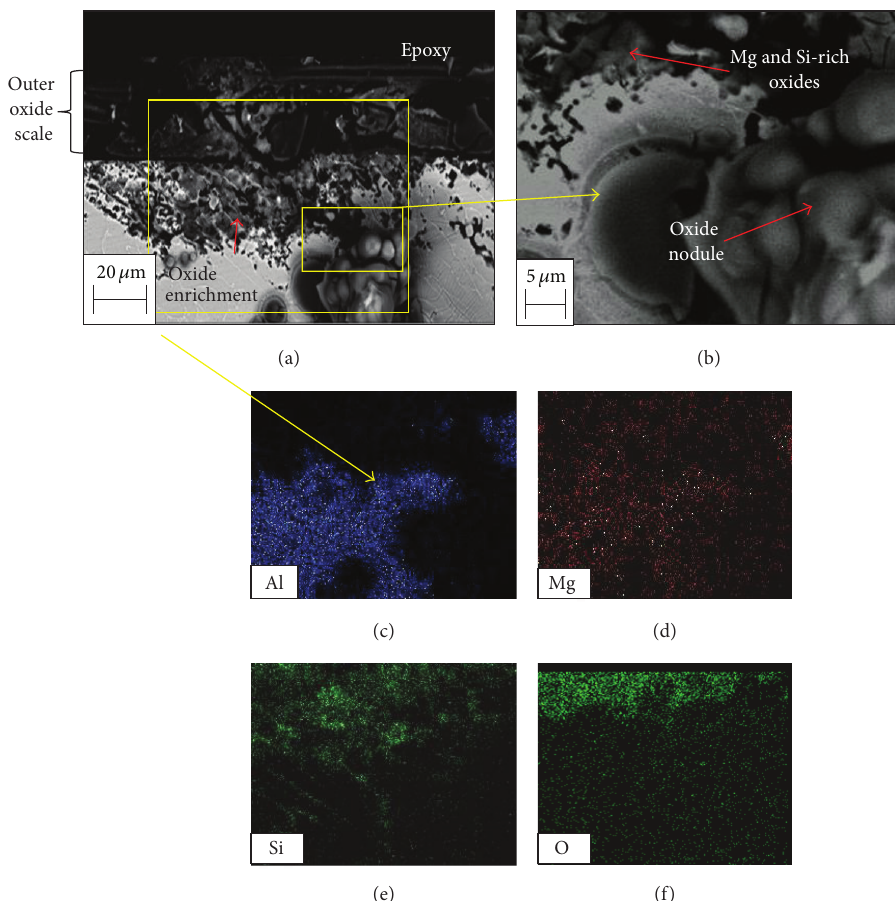
Figure 7: A cross-sectional image of fused metal part of welded AA6061 Al alloy oxidized at 600 ∘ C for 40 hours, (a) SEM image and (b) expanded SEM image in (a) and EDS maps analyses of (c) Al, (d) Mg, (e) Si, and (f) O.